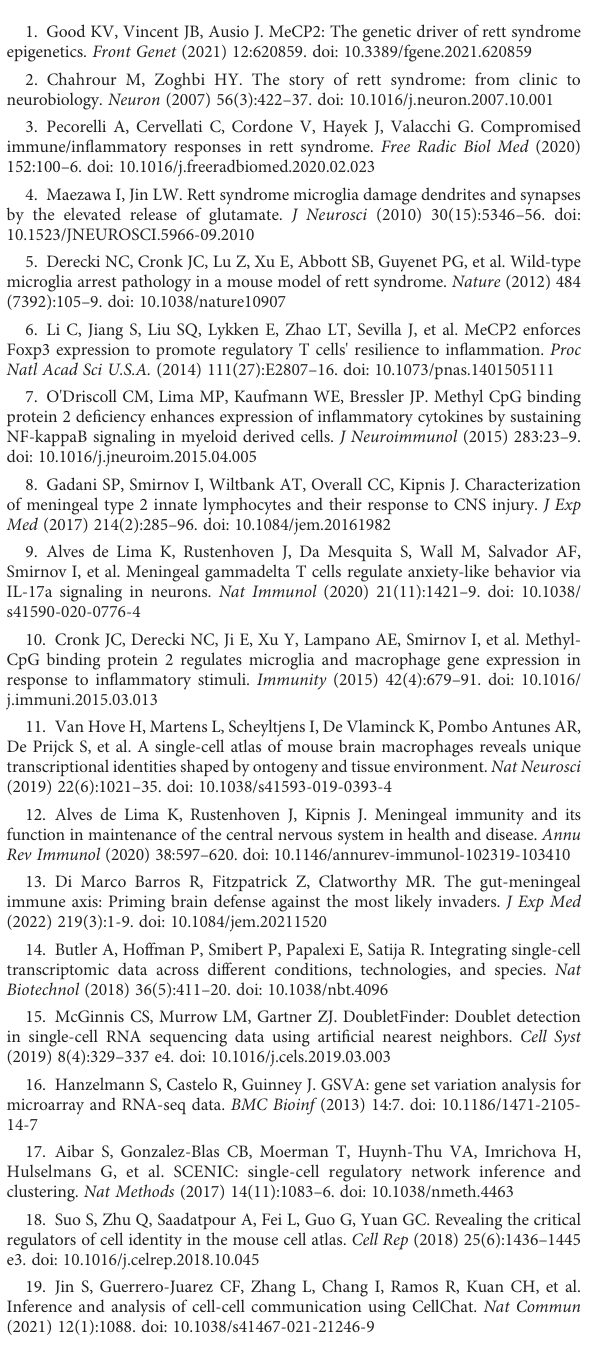
SUPPLEMENTARY FIGURE 2 Meningeal immune cells express Mecp2. (A) Representative confocal images of Mecp2 (red) and Lyve-1(green) staining in the dura mater of 1-month-old WT mice. Scale bars: 50 m m. (B) Violin plots representing the Log2 expression of Mecp2 in different meningeal immune cells from WT